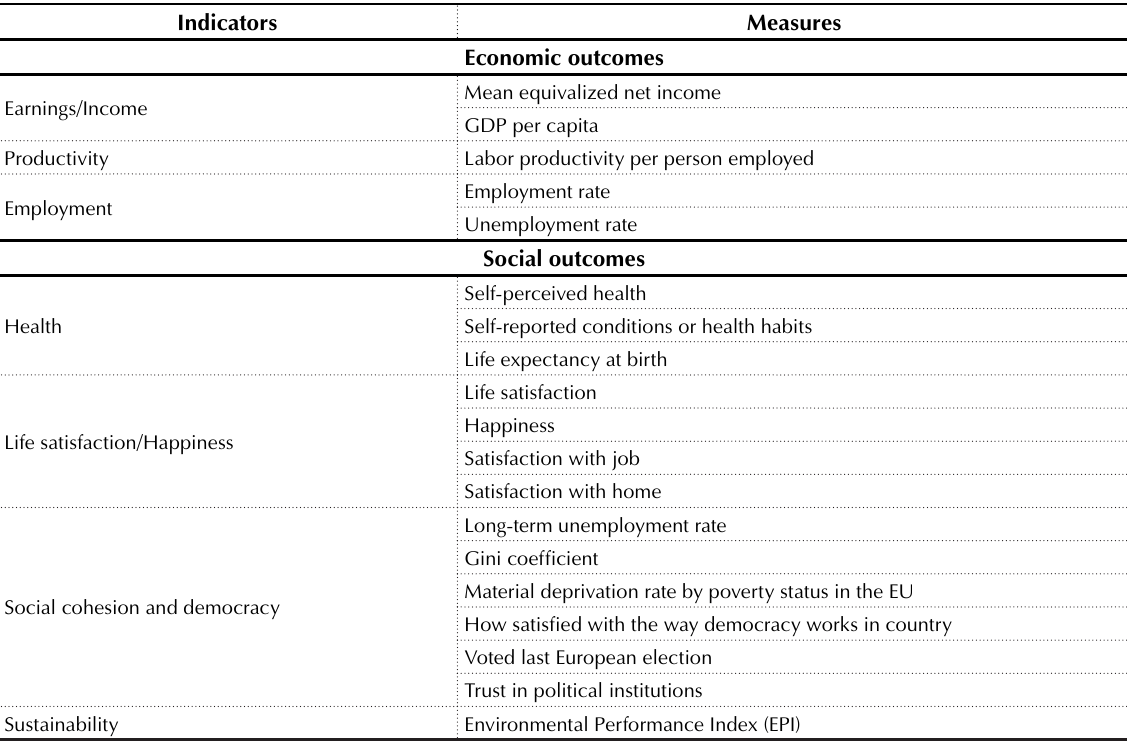
Table 6. Economic and social outcomes of learning